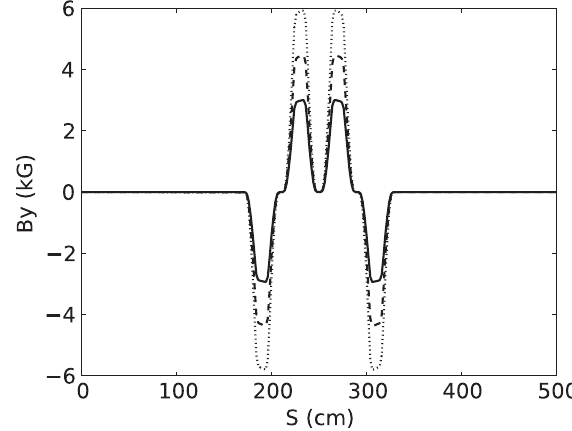
FIG. 54. Equilibrium orbits at 369, 549, and 729 MeV =c ¼ 11 and a DF ratio of 1.17. In ascending through cell with k=x 0 order of momentum the orbits are shown as solid, dashed, and dotted